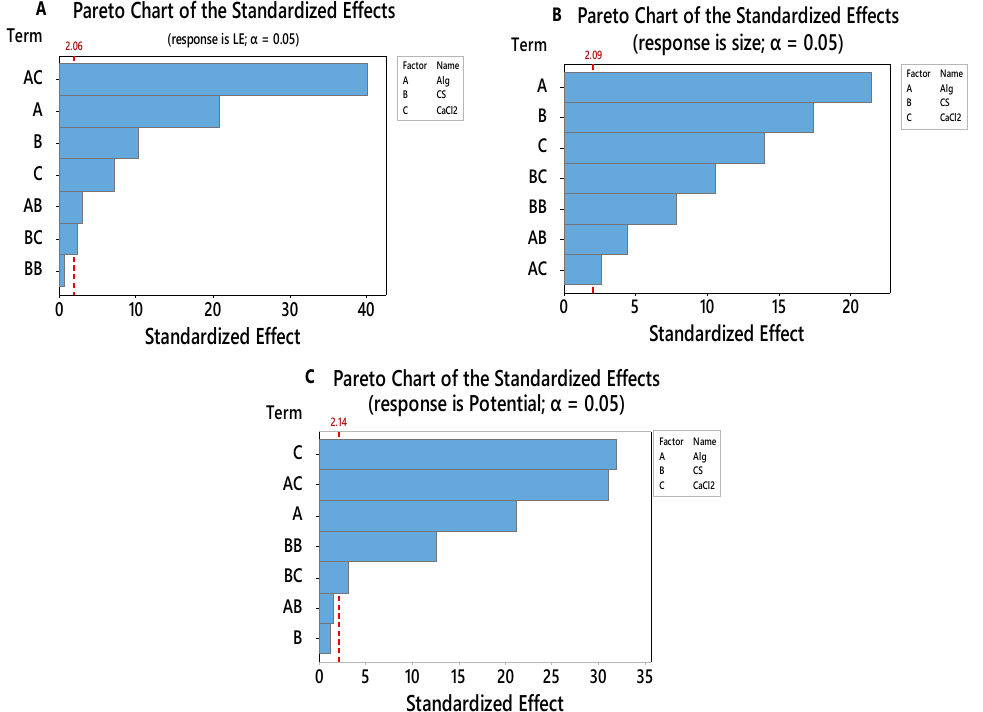
Figure 1. Pareto Chart of the standardized e ff ects toward LE ( A ), particle size ( B ) and zeta potential ( C ).